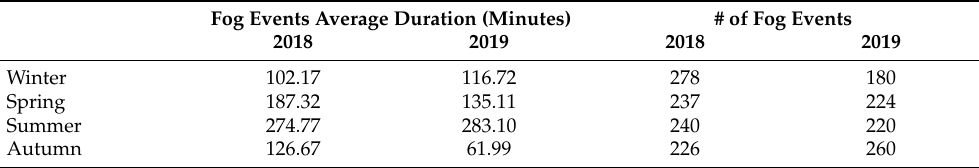
Table 7. Low-visibility events statistics at Mondoñedo station for the years 2018 and 2019, and for the 600 m threshold.